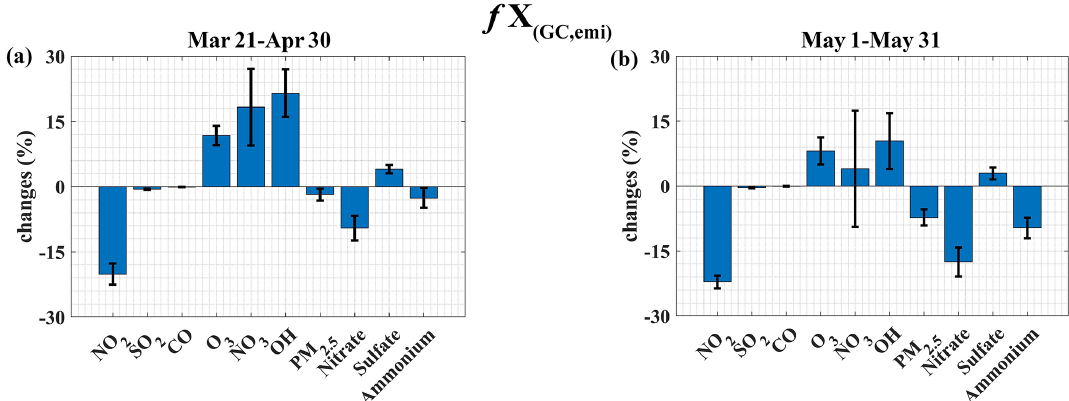
Figure 3. The GC NO 2 , SO 2 , CO, O 3 , NO 3 radical, OH radical, PM 2 . 5 , inorganic nitrate, sulfate, and ammonium concentration changes with emissions accounted for between 2020 lockdown and 2020 BAU (no lockdown) scenarios ( f X (GC , emi) ). Error bars represent the 1 σ of the mean of 10 metropolitan